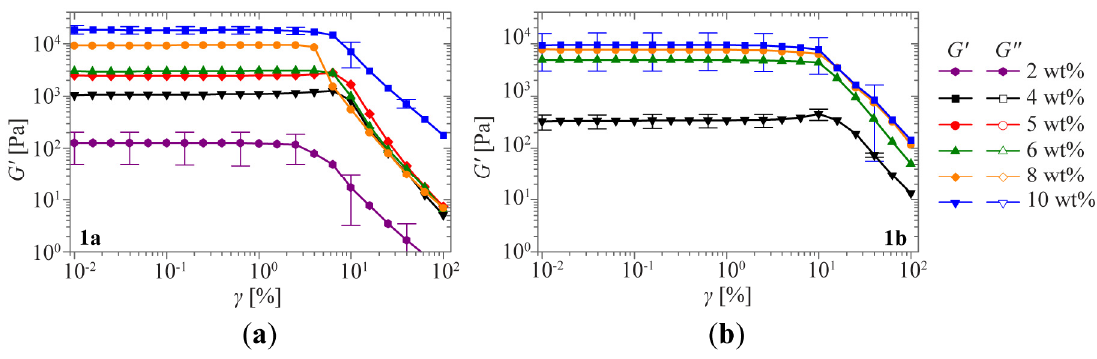
Figure 4. Time-Temperature Superposition for 1a at a concentration of 2 wt %. Rescaling of the original curves for 1a ( a ) at different temperatures ranging from 20 to 32.5 °C was performed using temperature-dependent shift factors a and the frequency ω , respectively. These shift factors are plotted ( c ) in an Arrhenius plot. The solid green line shows the linear fit to obtain the slope E